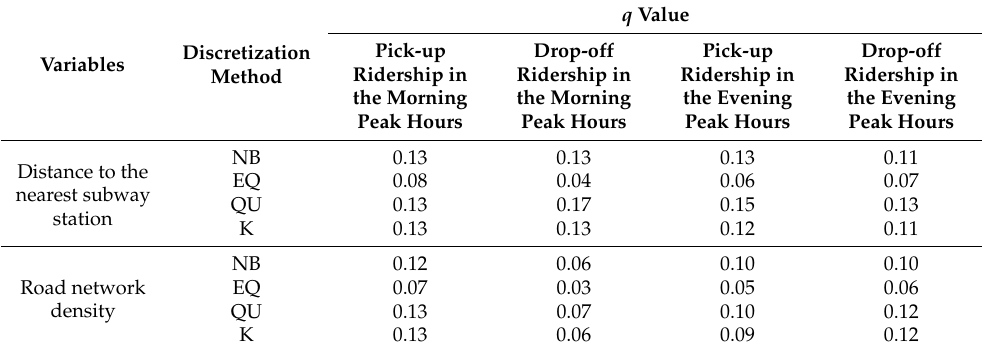
Table 5. The results for the q values of the geographical